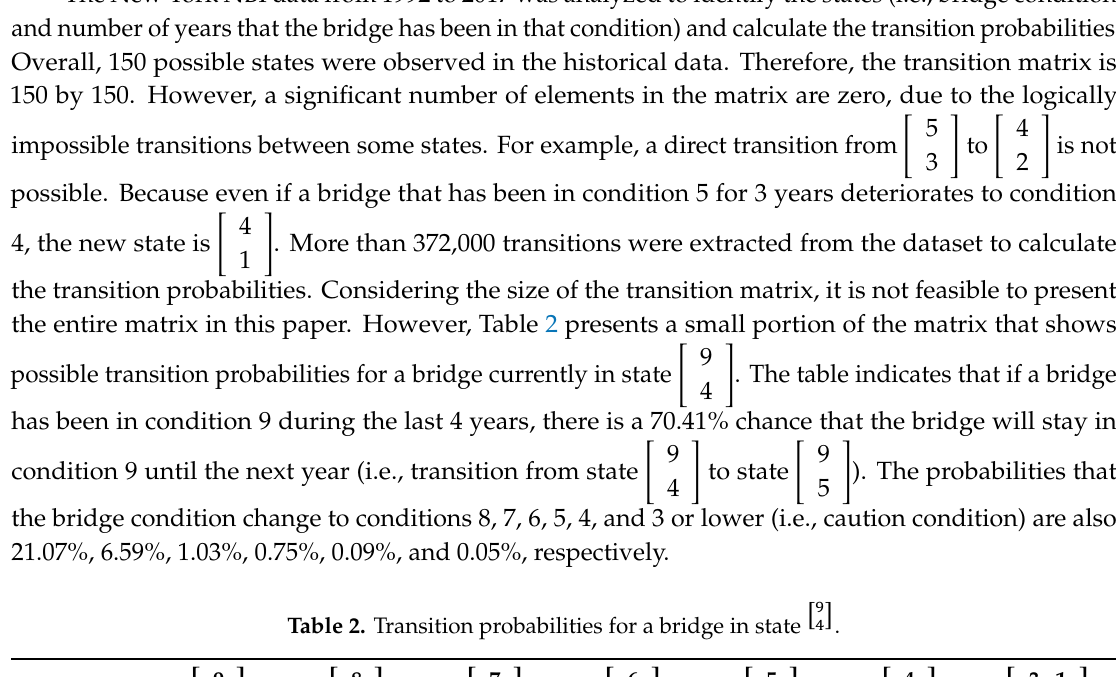
. The table indicates that if a bridge